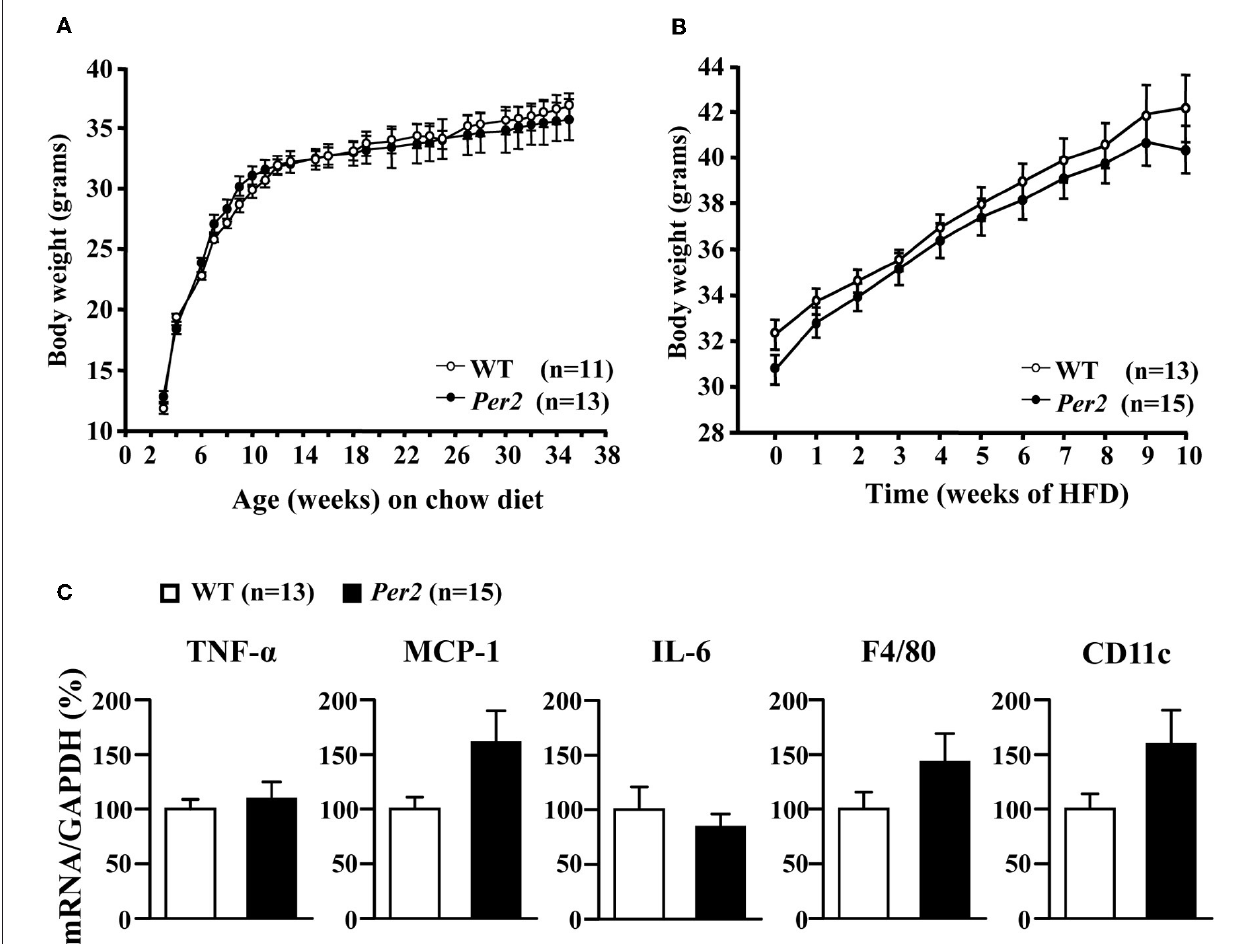
FIGURE 6 | Body weight development and diet-induced obesity of wild type (WT) and mPer2 Brdm1 mice. (A) Comparable body weight development on chow diet and (B) obesity on high fat diet (HFD) feeding between WT and mPer2 Brdm1 mice, and ( C ) qRT-PCR shows no significant difference in adipose tissue inflammation